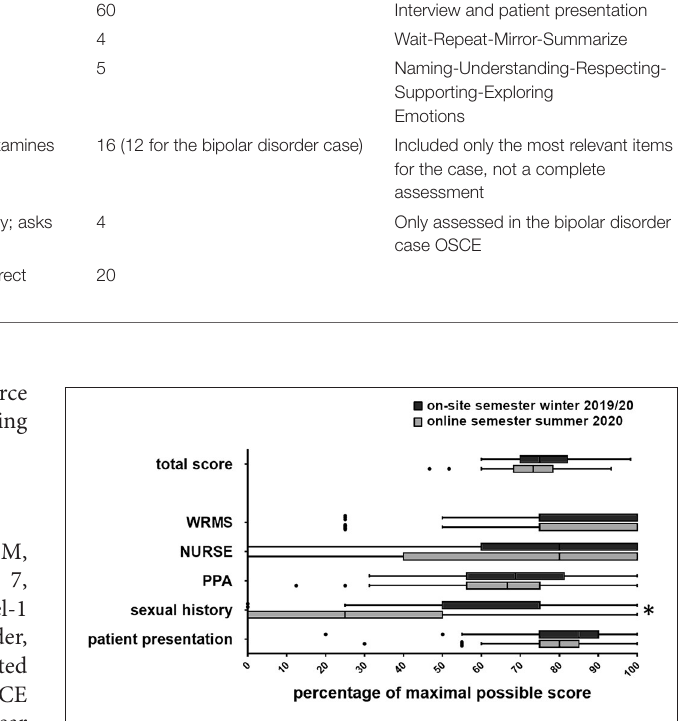
FIGURE 1 | Tukey plot of the OSCE results with sub scores (WRMS, Wait-Repeat-Mirror-Summarize-Model; NURSE, Naming-Understanding-Respecting-Supporting-Exploring-Emotions-Model; PPA, Psychopathological Assessment; Sexual history; Patient presentation). * p <